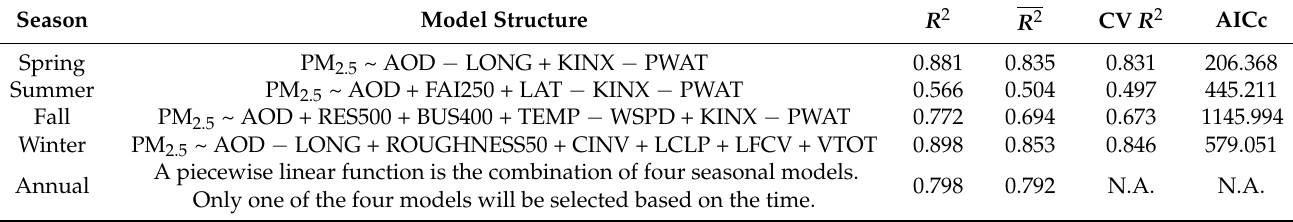
Only one of the four models will be selected based on the time.